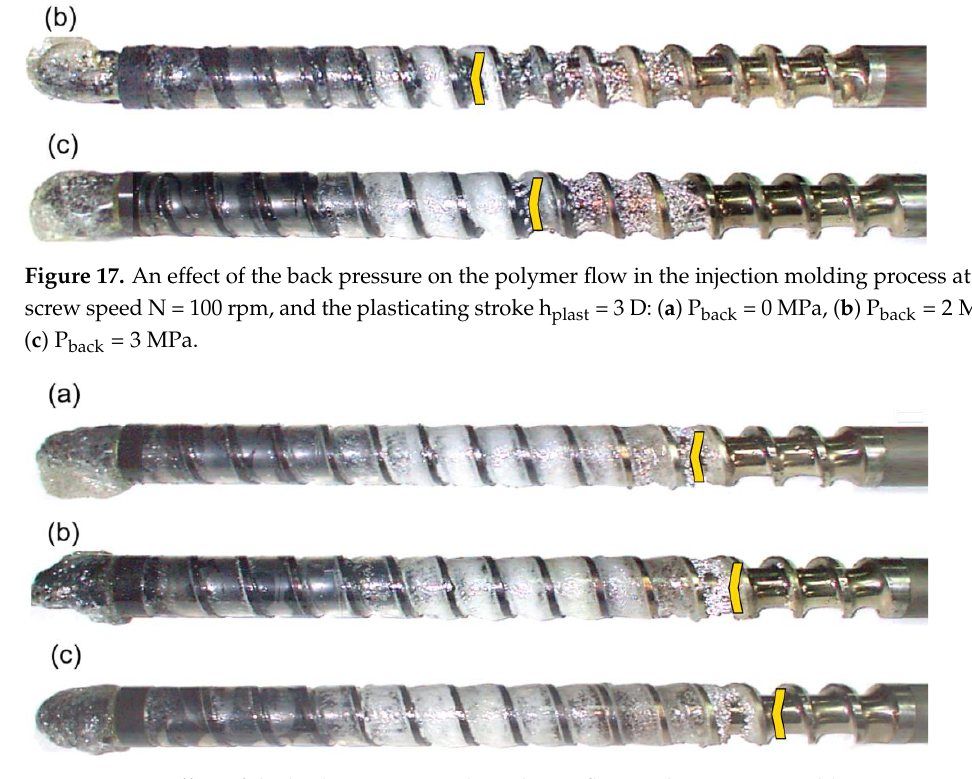
Figure 18. An effect of the back pressure on the polymer flow in the injection molding process at the screw speed N = 300 rpm, and the plasticating stroke h plast = 1 D: ( a ) P back = 0 MPa, ( b ) P back = 2 MPa, ( c ) P back = 3 MPa.